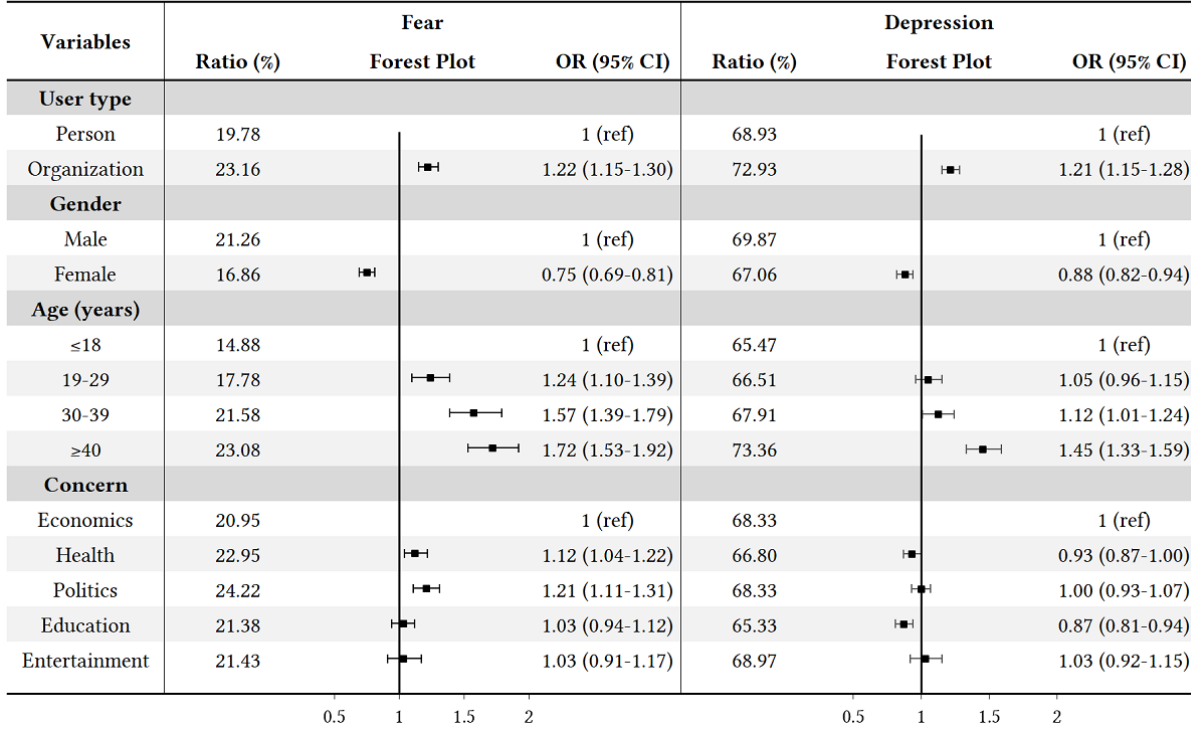
Figure 11. Statistical analysis of emotions related to COVID-19. OR: odds